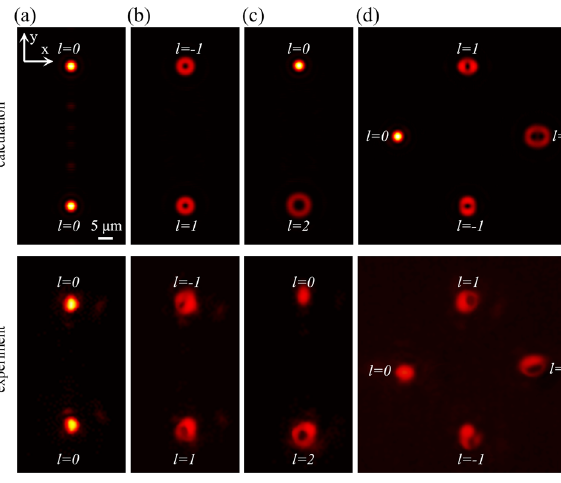
Figure 4: Theoretical calculations and experimental results of the focused multi-channel OAM beams achieved by holography multiplexing. Two-channel beams with (a) l = 0 and0, (b) l = − 1 and1, (c) l = 0 and 2. (d) Four-channel beams with l = − 1, 0, 1, 2. All of them have